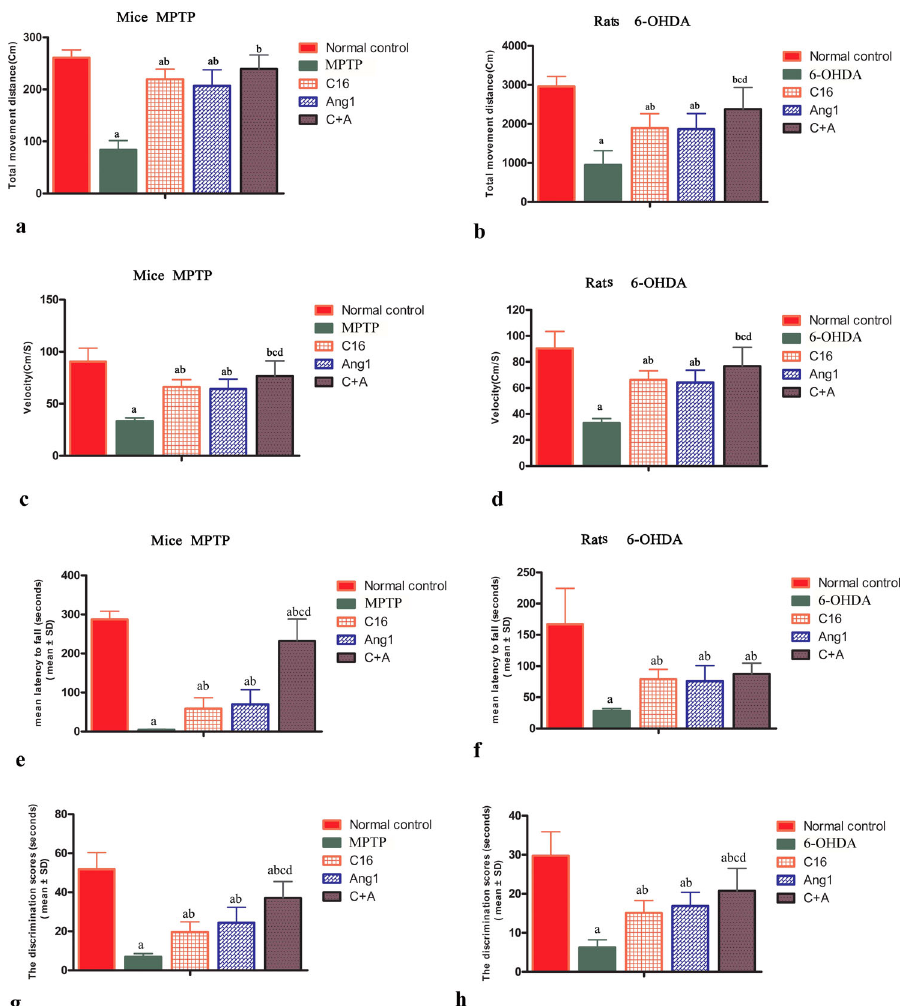
Fig. 1 C16 in combination with Ang-1 treatment improved the functional impairment. a – d Measurements of total traveled distance ( a : mice; b : rats) and mean velocity ( c : mice; d : rats) of each group in the open fi eld test. The motor function assessment revealed neurological disabilities in model animals. a – f C16 or Ang-1 alone ameliorated functional impairment in PD animals, while the combination of C16 and Ang-1 exhibited more potent therapeutic effects including the reduction in the mean velocity of both animal models in the open fi eld test, decreased distance traveled in 6-OHDA-treated rats, and increased time on the rotarod test device in MPTP-treated mice. g , h PD animals showed an impaired ability to recognize objects, while treatment with C16 or Ang-1, and especially with C16 plus Ang-1 alleviated memory issues. a p < 0.05 versus the normal control group; b p < 0.05 versus the p < 0.05 versus the MPTP/6-OHDA insult group; c p < 0.05 versus the C16-treated group.; d p < 0.05 versus the Ang-1-treated group. C16, peptide (KAFDITYVRLKF) that can selectively bind integrin α ν β 3 ; Ang-1 angiopoietin-1; PD, Parkinson ’ s